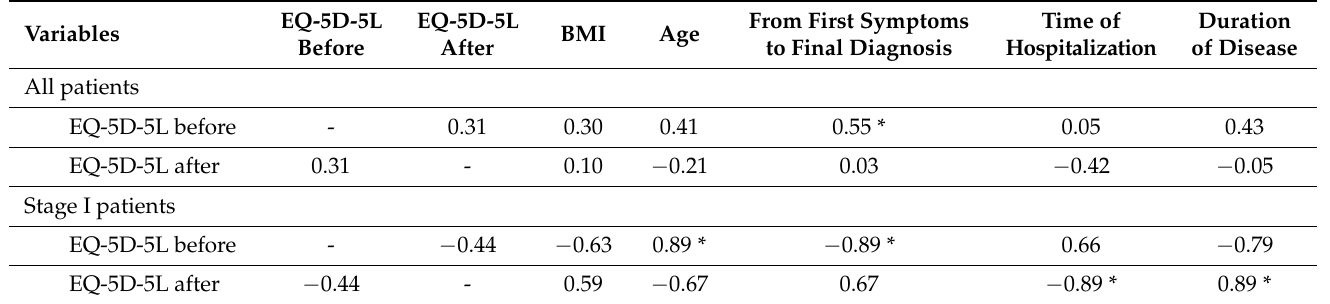
Table 3. Spearman’s rank correlation coefficients (r s ) between factors potentially influencing health- related life